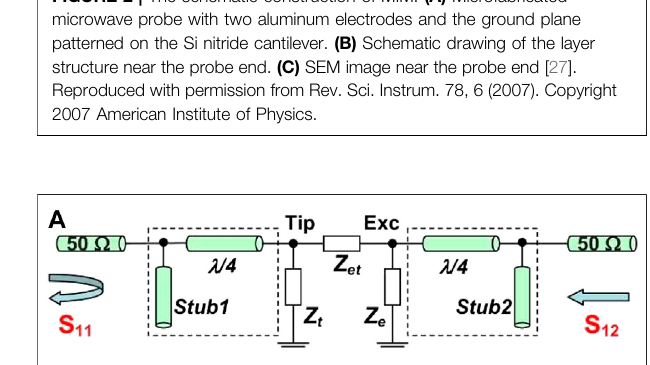
FIGURE 3 | Impedance matching section. A λ /4 cable and a tuning stub (inside the dashed boxes) form the interface between the probe and the 50 Ω feed lines [28]. Reproduced with permission from Rev. Sci. Instrum. 79, 6 (2008). Copyright 2008 American Institute of